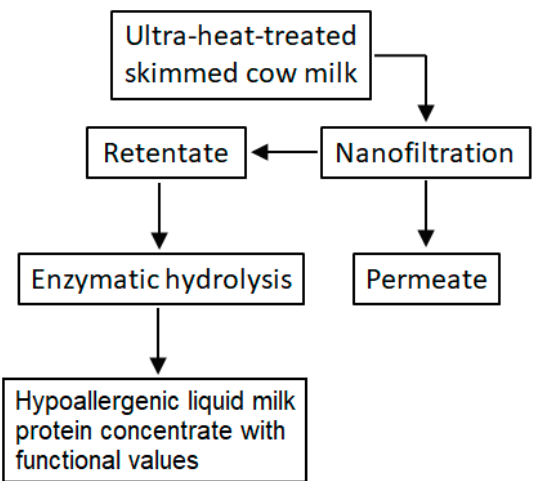
Figure 1. Experimental steps for preparing hypoallergenic liquid milk protein concentrate with functional values (antioxidant capacity, angiotensin converting enzyme inhibitory activity, and antibacterial activity).